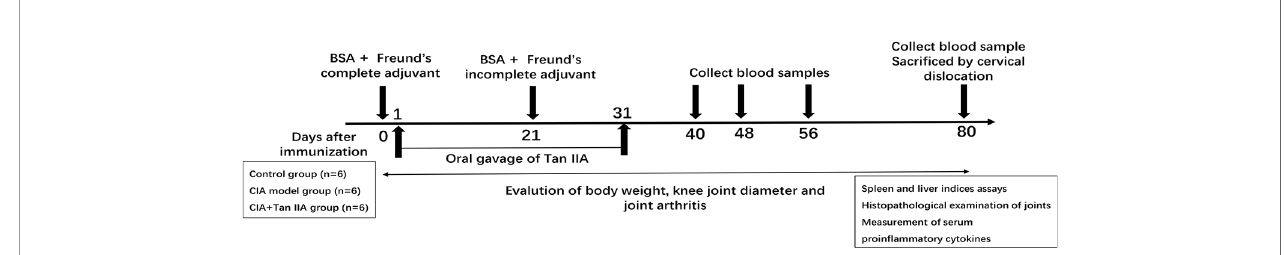
FIGURE 1 | Study design of the AIA experiment. Male C57BL/6 mice aged 10 – 12 weeks were immunized at each side of the knee articular cavity on day 0, and second immunizations were performed on day 21. From day 2 to day 31 after immunization, mice were administered with oral gavage Tan IIA once a day consecutively, as described in the Materials and Methods. Body weight and knee joint diameter were measured every 5 days. Blood samples for proin fl ammatory cytokine analysis were collected on days 40, 48, 56, and 80. The mice were euthanized at day 80, and bone, spleen, liver, and serum samples were collected. Histopathological analysis was performed on the bones of knee joints. Spleen and liver indices were calculated by weighing spleen and liver. Serum samples were subjected to